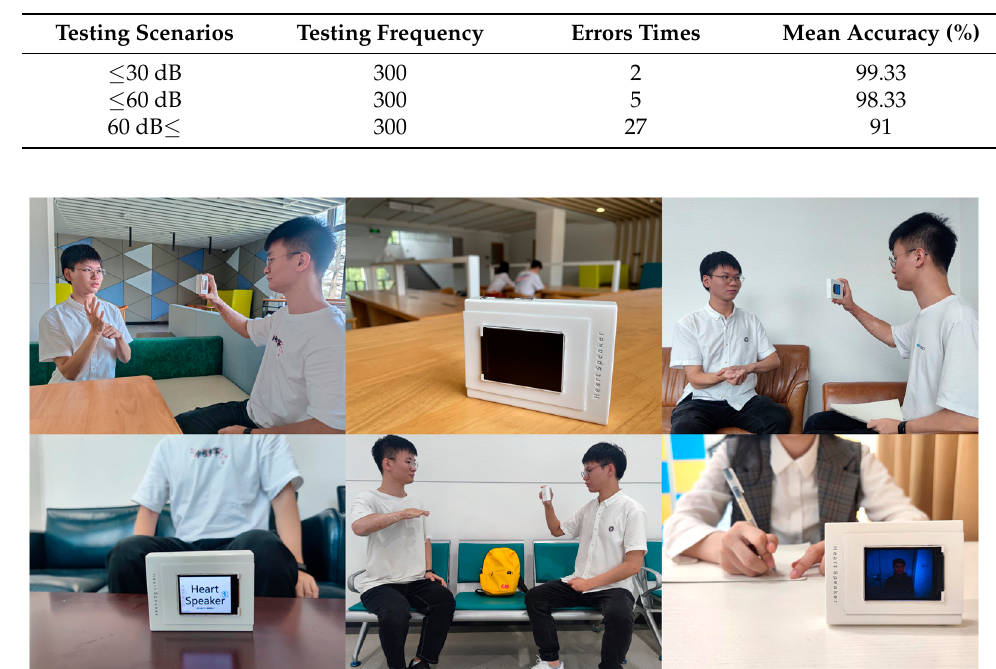
Figure 12. Different scenarios for testing speech